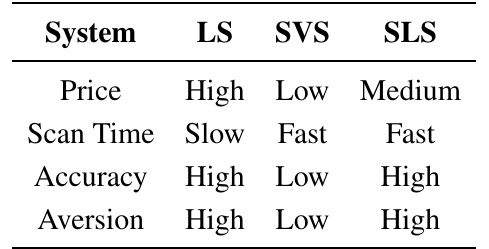
Table 1. Comparison of three-dimensional (3D) acquisition systems: laser scanner (LS), stereo vision system (SVS), and structured light system